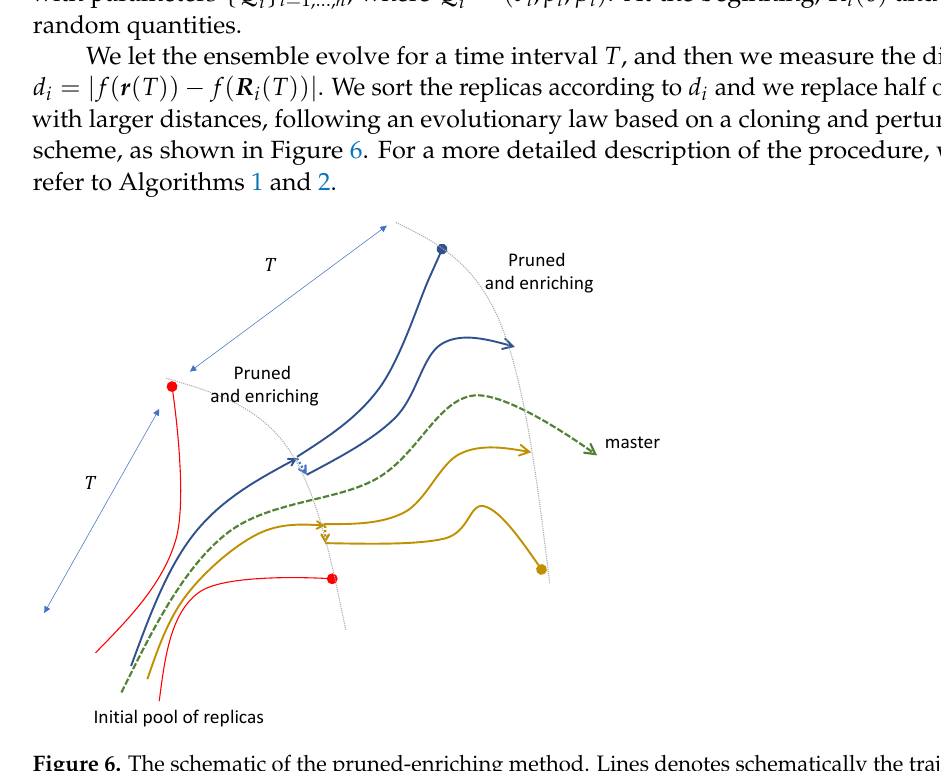
Figure 6. The schematic of the pruned-enriching method. Lines denotes schematically the trajectories of replicas in the space of state variables and parameters. The dashed lines marks the trajectory of master system. Disks marks the elimination of replicas which are farther from the master one. Black dotted lines marks the pruning and enriching times, and the duplication of replicas are marked by the dashed colored lines with arrows. The variation of the duplication of the nearer replicas is either on one of the state variables or one of